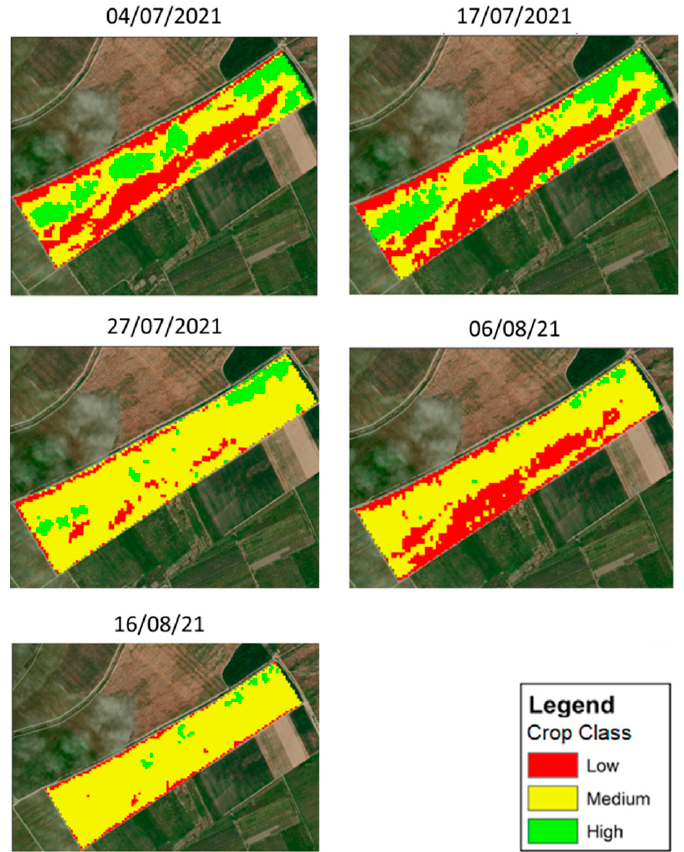
Figure 3. Example of the NDVI maps generated throughout the cultivation season in the respective data collection dates for a single field, in quantile classification using all Khachmaz pilot fields.